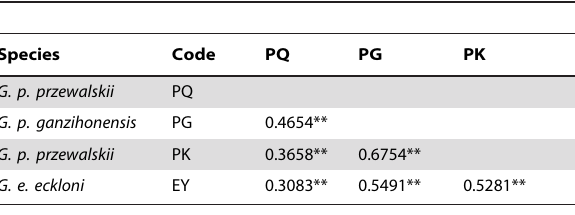
Table 4. F st values among species or populations based on the combined sequence